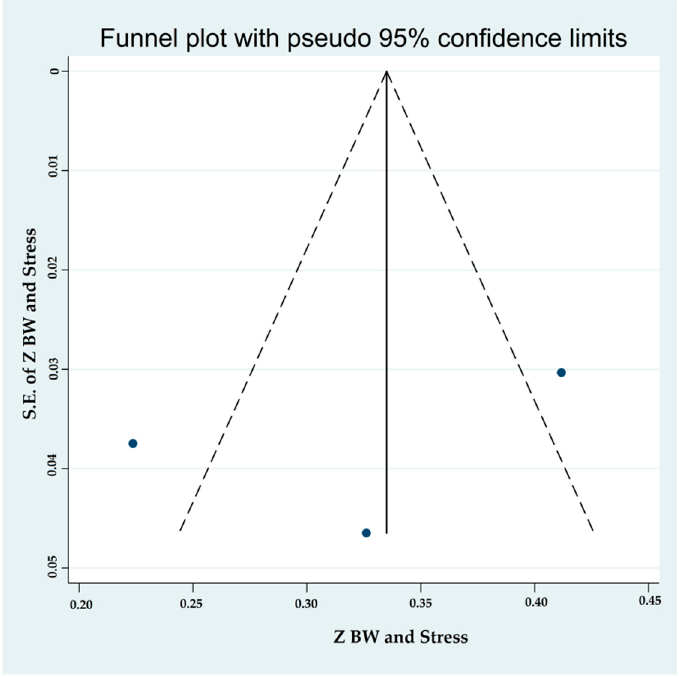
Figure 10. The funnel plot displaying the estimated pooled Fisher’s z-score in the association between binge-watching and stress.